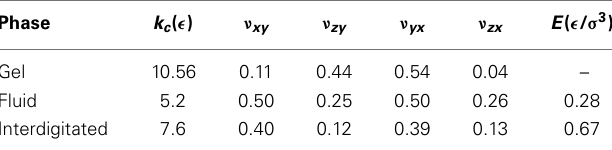
Table 3 | Elastic constants obtained from simulations of lipid membranes in different